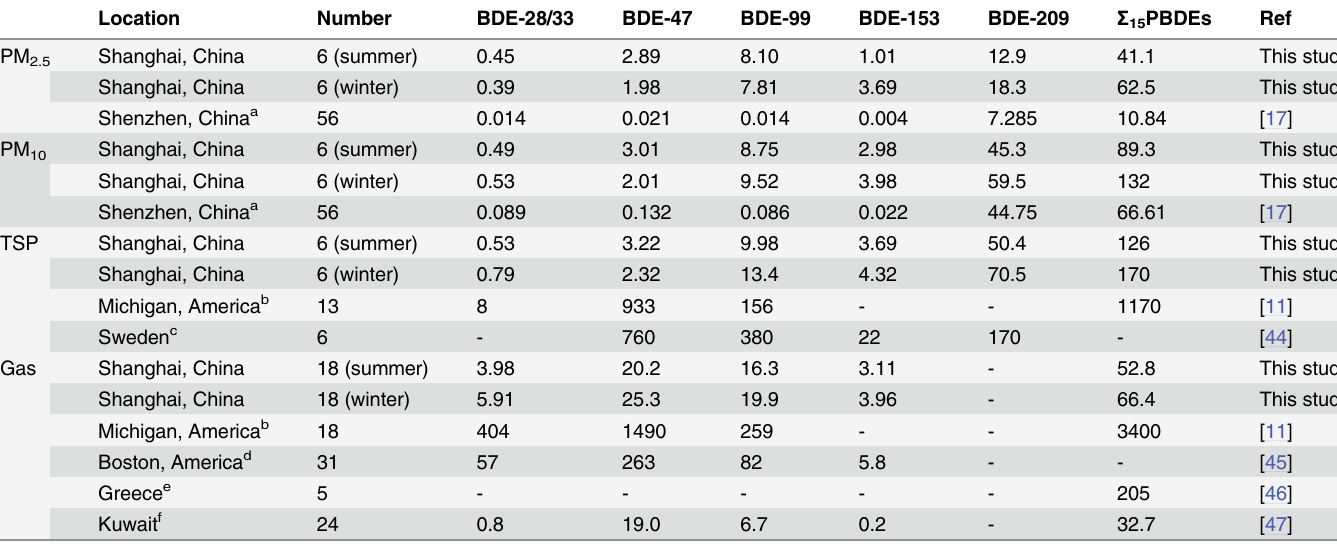
Table 2. Comparison of PBDEs concentrations in PM 2.5 , PM 10 , TSP and gas phase in of fi ce environment (pg/m 3 ).